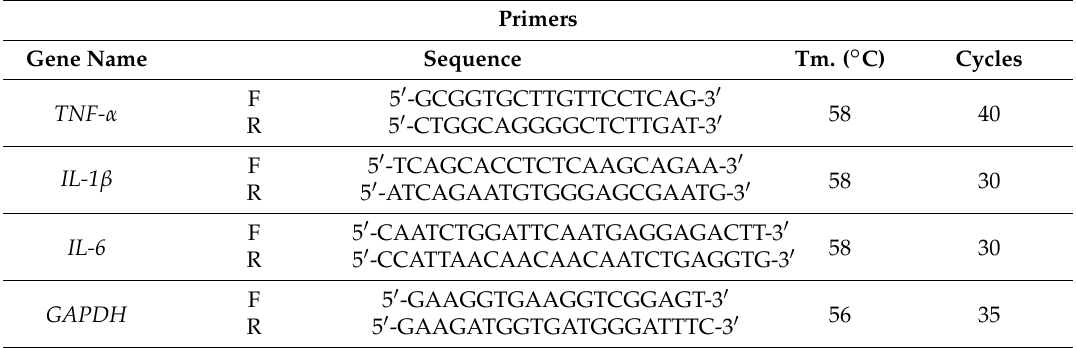
specific primers in Table 1. PCR products were electrophoresed on 1% agarose gels and visualized by GreenLight (BioAssay Co., Daejeon, Korea). The following PCR conditions are indicated in Table 1. Table 1. Primer sequences, annealing temperature, and cycles used for reverse transcription polymerase chain reaction